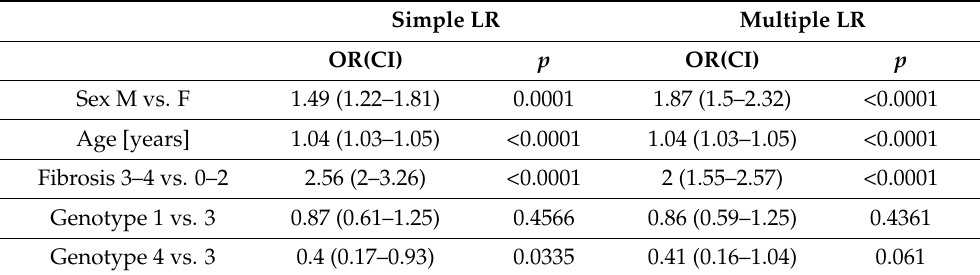
Table 5. Factors related to the incidence of diabetes—results of logistic regression OR (CI): odds ratio with 95% confidence